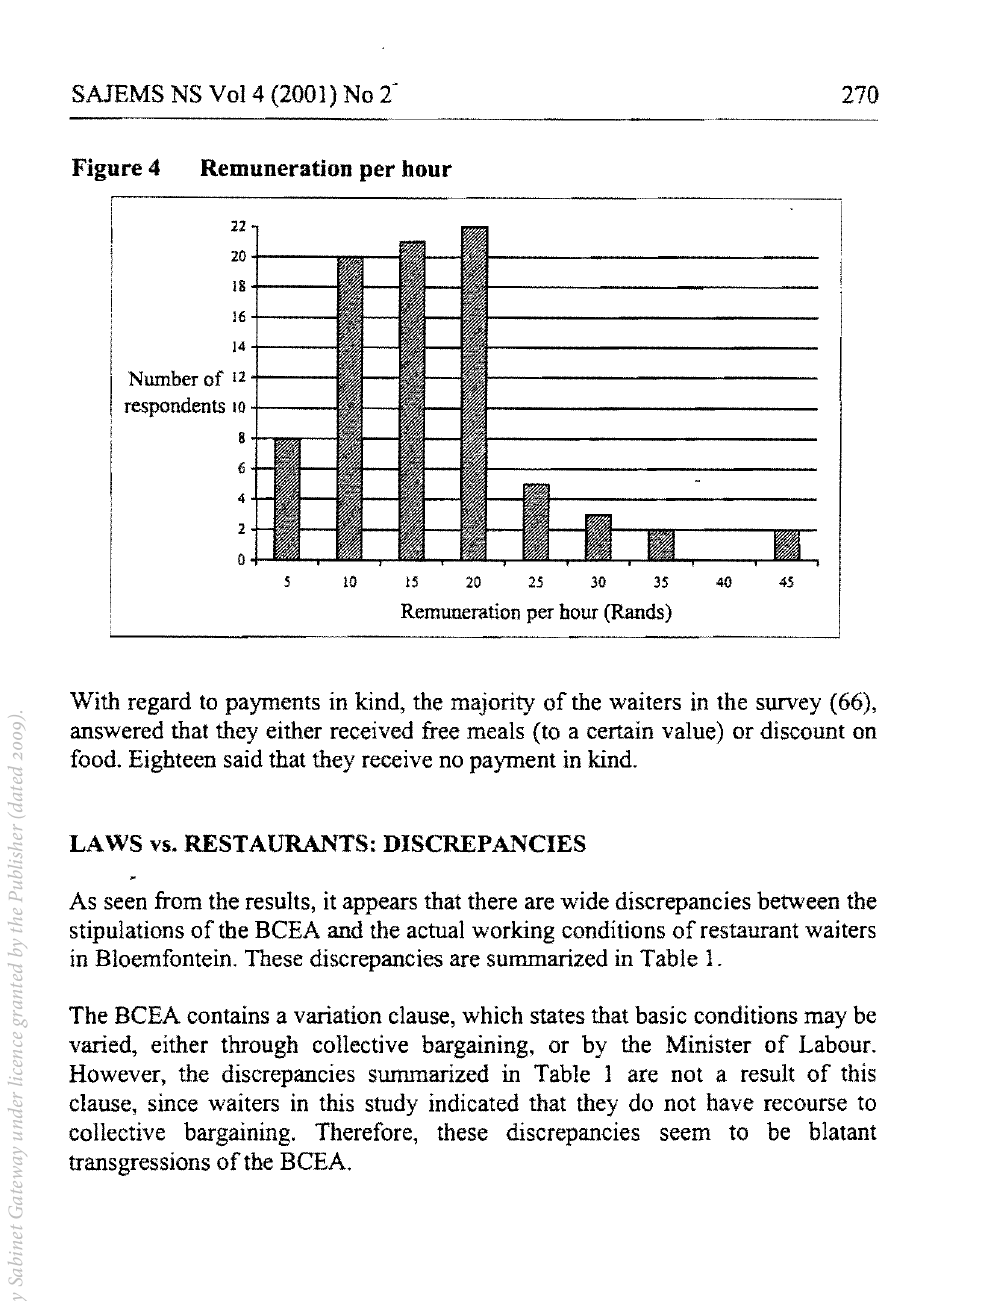
Remuneration per